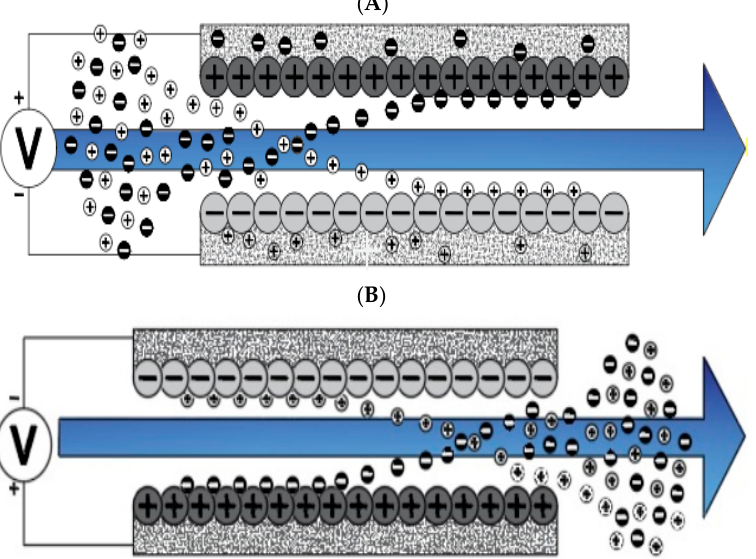
Figure 1. Water desalination process with capacitive deionization method. ( A ) The phase of ion adsorption ( B ), Electrode Regeneration steps.